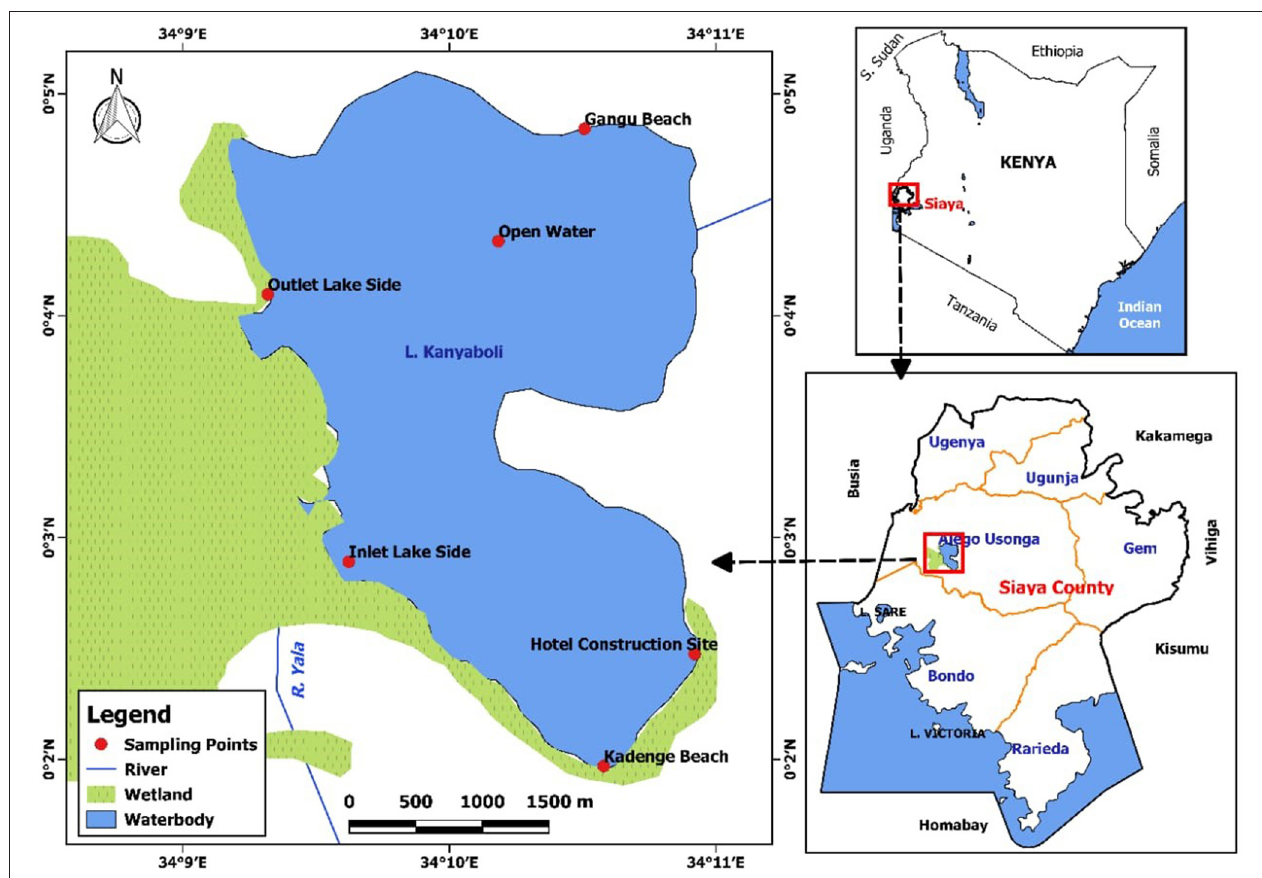
FIGURE 1 | Map showing sampling sites in Lake Kanyaboli for February 2020–February